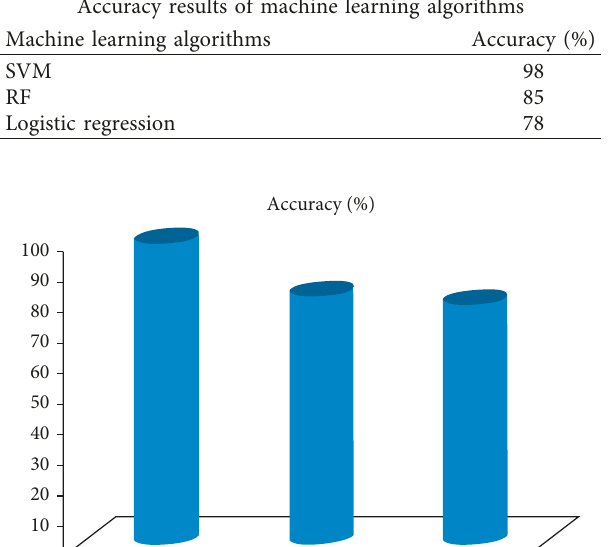
Figure 3: Accuracy of classifiers.